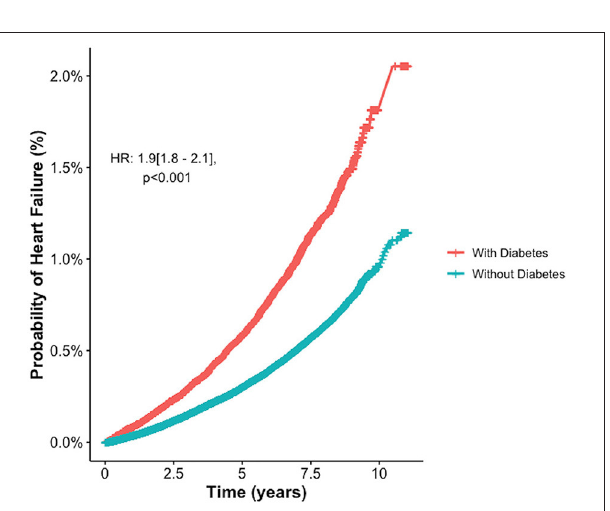
FIGURE 3 | Increased probability of incident Heart Failure in Diabetes: a multivariate analysis. HR, hazard ratio. compared to men (hazard ratios 4.7 (3.6–6.2) vs. 2.5